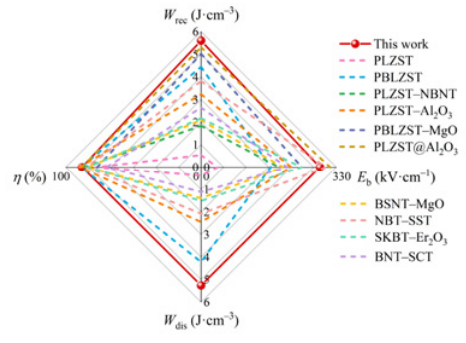
Fig. 9 A comparison of the E b , W rec , ƞ , and W dis of the PBLZST:1.0 wt% AlN composite ceramics in this work with PLZST-based ceramics and other composite